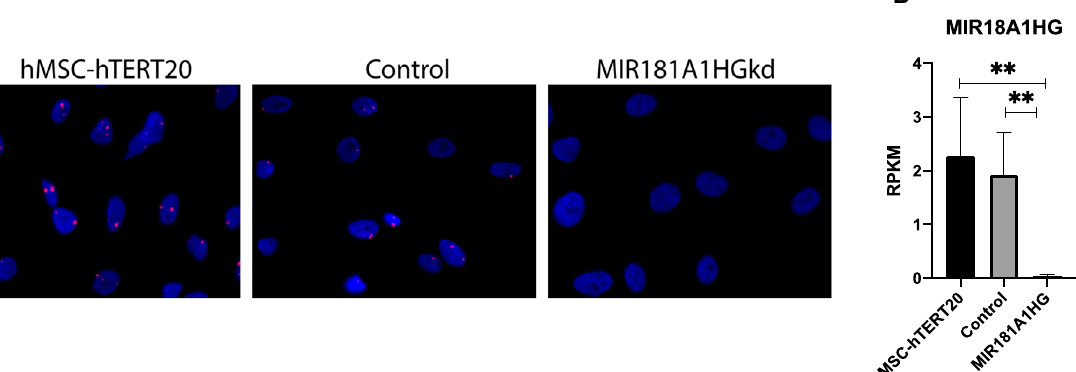
Figure 2. MIR181A1HG is a nuclear lncRNA expressed highly in proliferating MSCs and expression is depleted by CRISPRi. ( A ) Representative RNA-FISH images of MIR181A1HG in hMSC-hTERT20 (left), CRISPRi control (middle) and MIR181A1HGkd (right) cells. Red spots indicate expressed RNA. Nuclei are counterstained with DAPI. Scale bars represent 20 µm. ( B ) RNA transcript levels in reads per kilobase million (RPKM) of MIR181A1HG in parental hMSC-hTERT20 (n = 6), CRISPRi control and MIR181A1HGkd cells (n = 3), as assessed by RNA-Seq. **padj < 10 –4 . Data are presented as mean ±